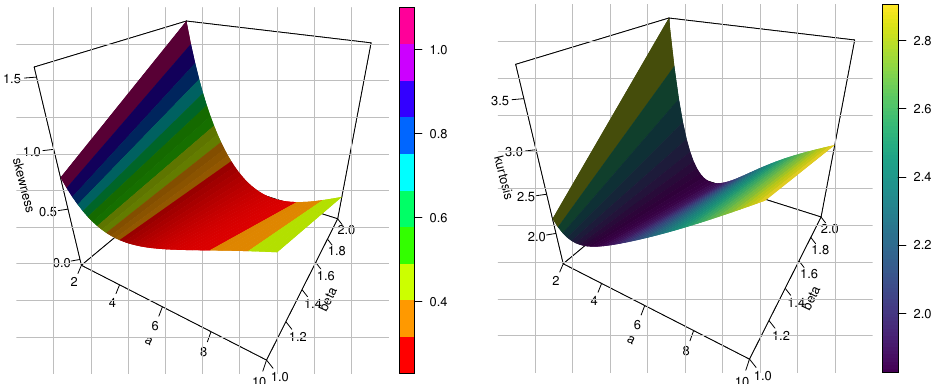
Figure 5. Three-dimensional plots of mean, variance, CS, and CK for the TCP-ITL model at a ∈ [ 2,10 ] , β ∈ [ 1,2 ]